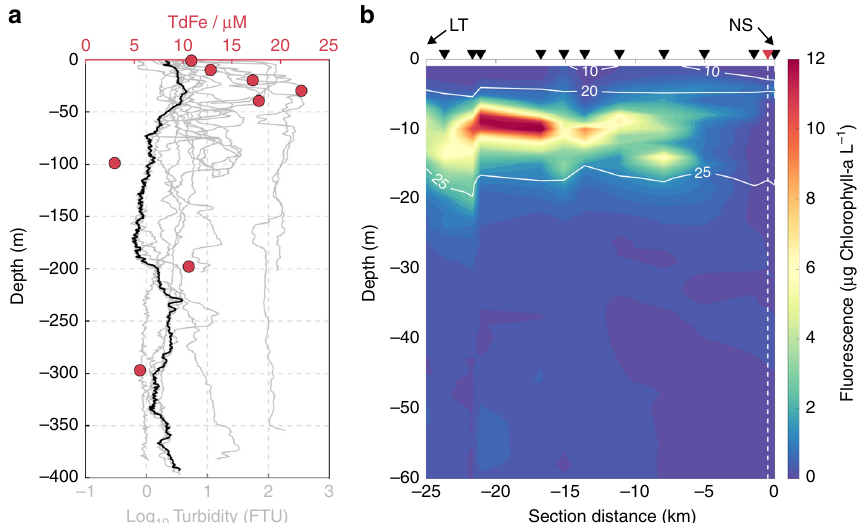
Fig. 2 Water properties in inner Godthåbsfjord (SW Greenland). a Turbidity pro fi les (gray lines) from all available data within ~5 km of the calving face of the marine-terminating glacier Narsap Sermia (NS), and total dissolvable iron (TdFe, red dots) at a station ~6 km away from NS together with turbidity for this station (black line, June 2015). b Fluorescence (June 2015) indicating the presence of a summer phytoplankton bloom. Contours show potential density anomaly (kg m − 3 − 1000). NS is located 5 km further into the fjord, Lake Tasersuaq (LT) out fl ow is also indicated. The dashed line and red triangle correspond to the location of the black turbidity and TdFe data in